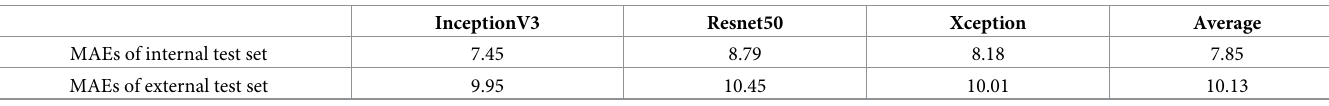
Table 2. Comparison of MAEs for regression prediction of PASP in internal and external